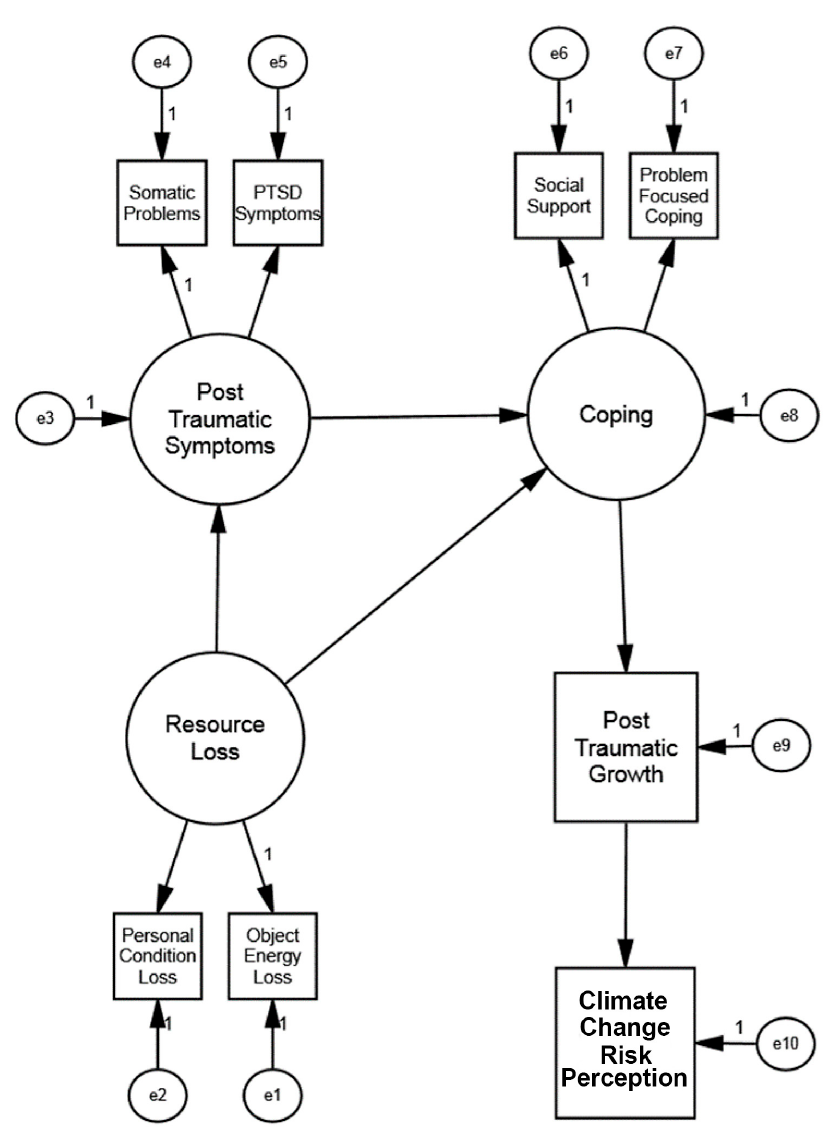
Figure 1. (Study 1, Philippines) . Initial Hypothesized Model: Influence of Resource Loss on Posttraumatic Symptoms, Coping, Posttraumatic Growth, and Climate Change Risk Perception.